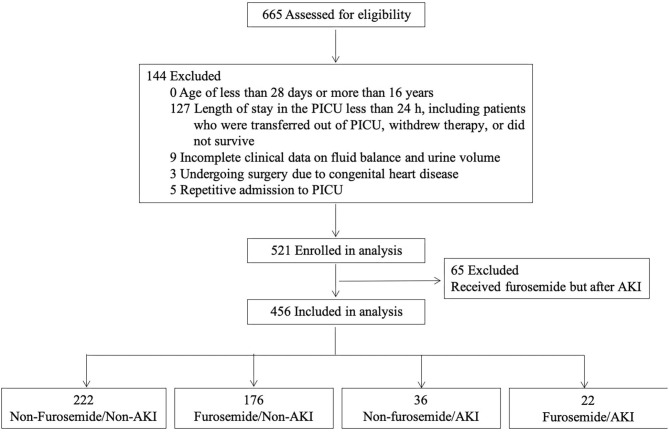
Study flow diagram.